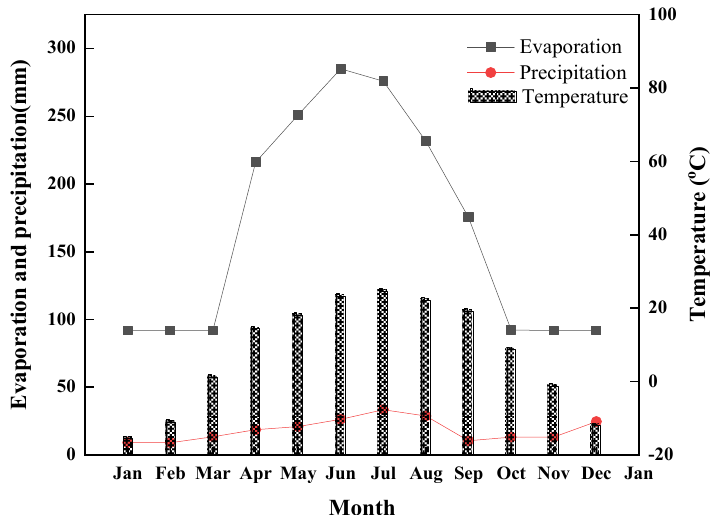
Figure 1. Average evaporation, precipitation, and ambient temperature during a long-term experi- ment from 1990 to 2014 in a gray desert soil.